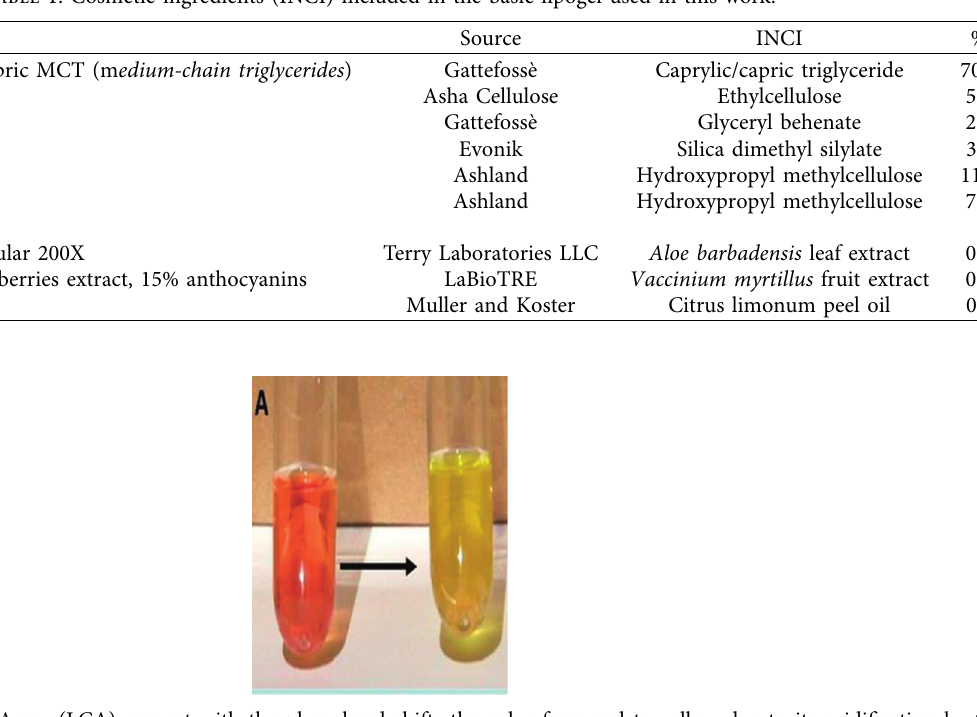
Table 1: Cosmetic ingredients (INCI) included in the basic lipogel used in this